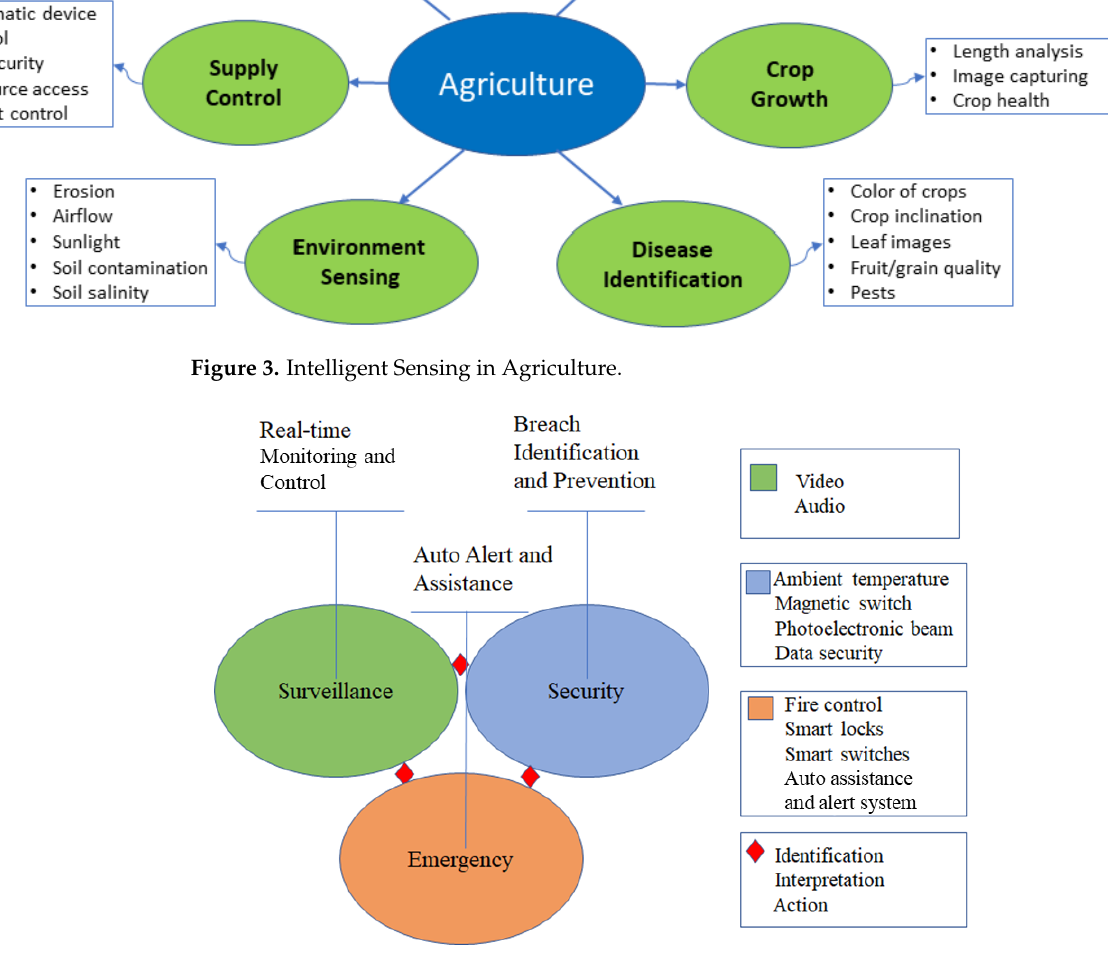
Figure 4. Intelligent Sensing in Intruder Detection and